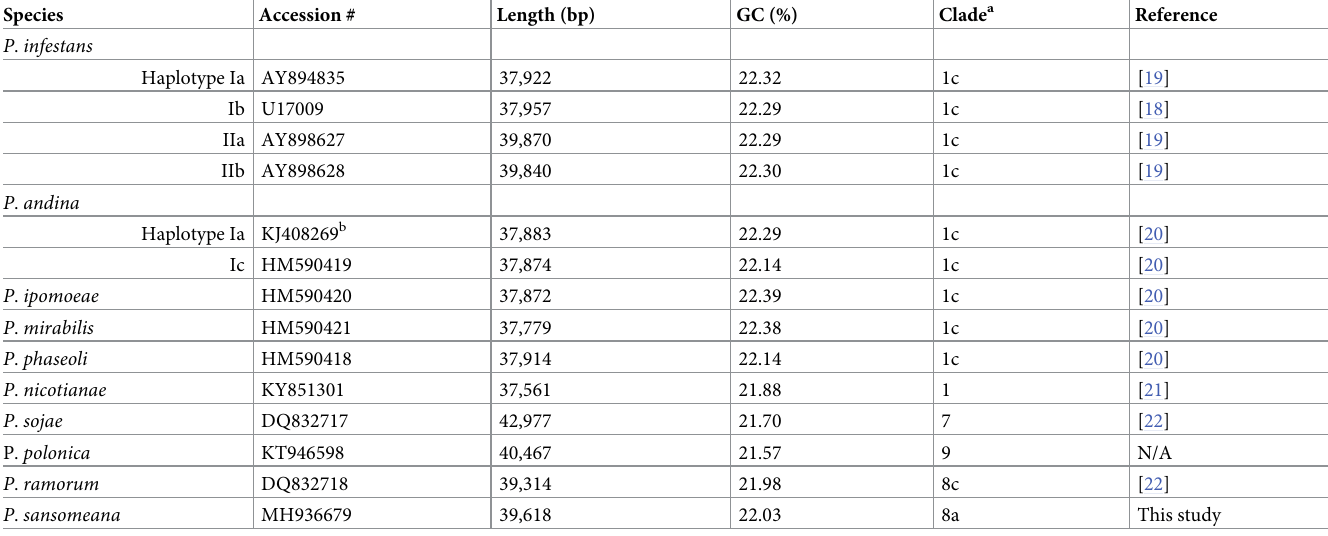
Table 1. Mitochondrial genomes of 10 Phytophthora species included in the analysis in this study.